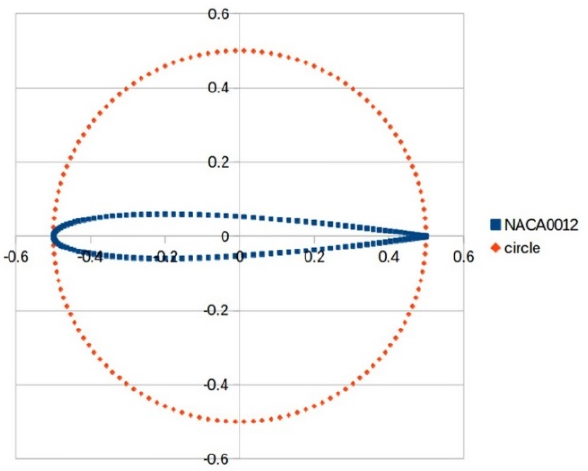
Figure 2. Control points (red) and displaced points (blue).